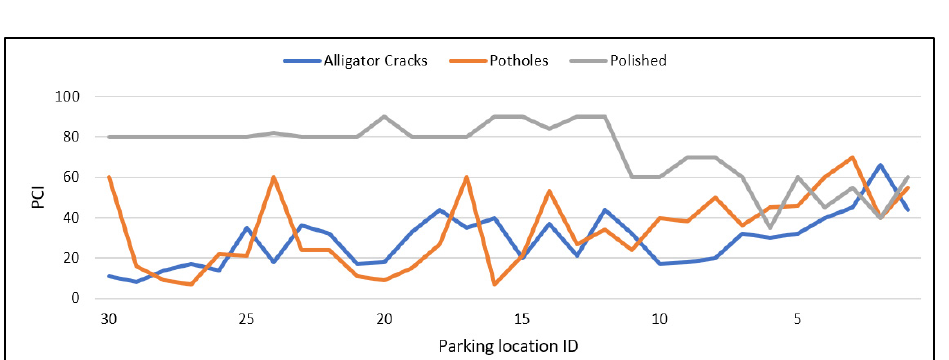
Figure 7. The distribution of PCI values along the parking site for Alligator cracks, Pothols, and polished aggregate.